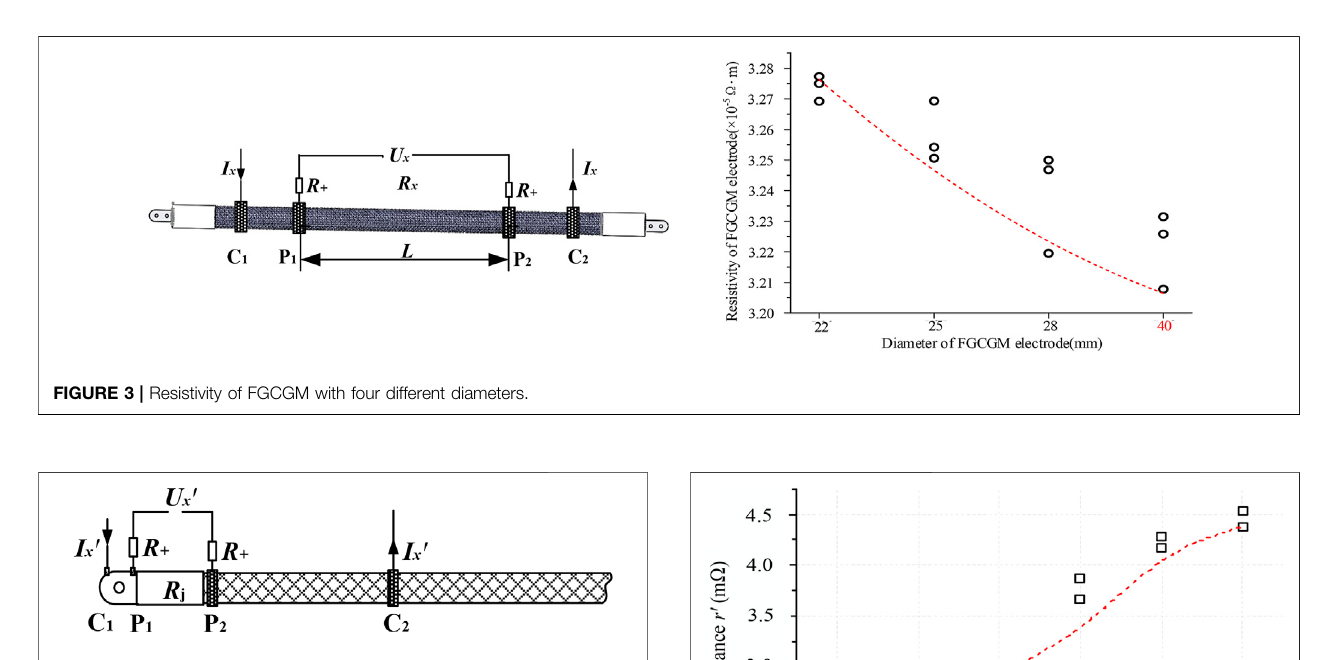
FIGURE 4 | Diagram of splicing resistance measurement.